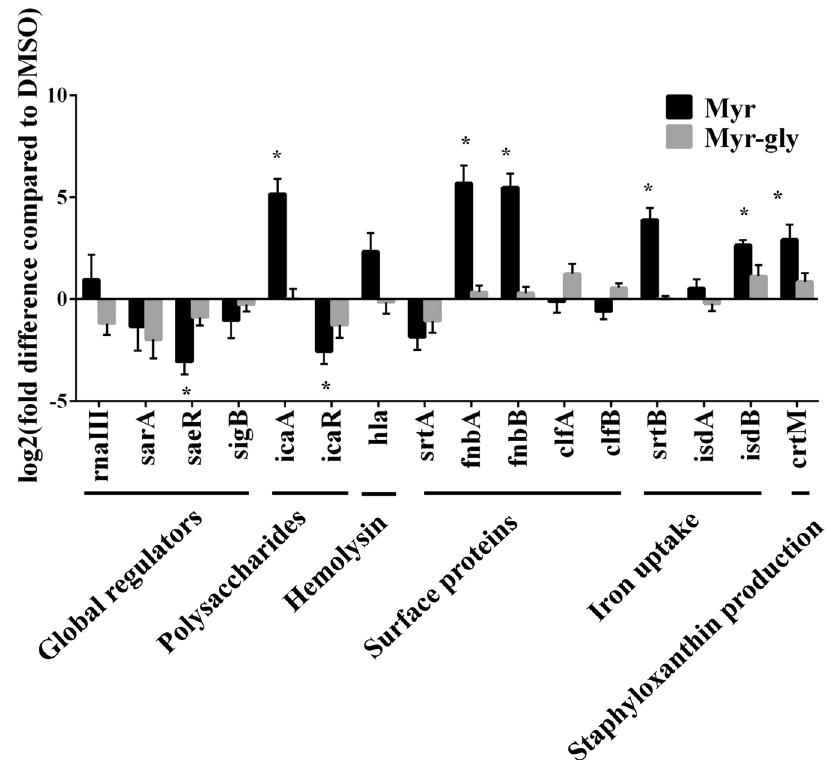
Figure 4. Transcriptional profile of S. aureus virulence genes upon treatment with Myr or Myr-gly. Transcript abundance was determined by qRT-PCR on cells grown for 2.5 h in BHI. The data are based on biological triplicates and the expression levels depicted are the mean log2 (fold difference) and standard deviations. * Represents significance level of p ≤ 0.02. Methodology can be found in Supplementary